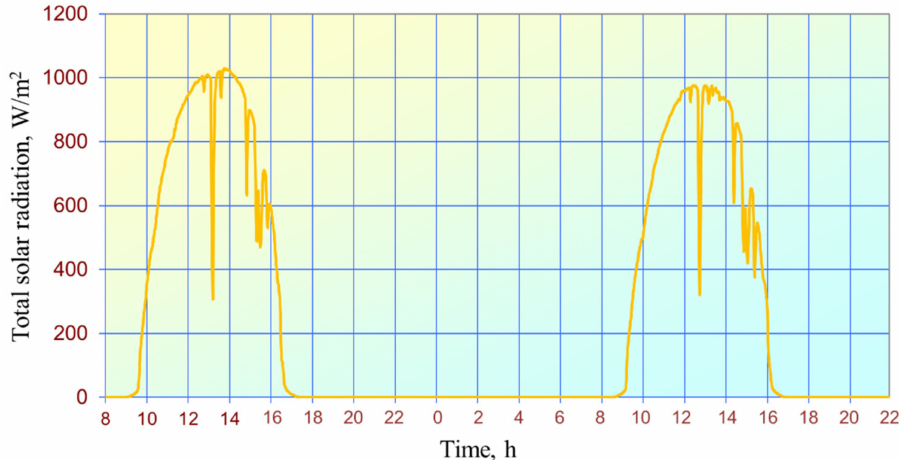
Figure 10. Time dependence of total solar radiation (W/m 2 ) for two days (26–27 November 2020).